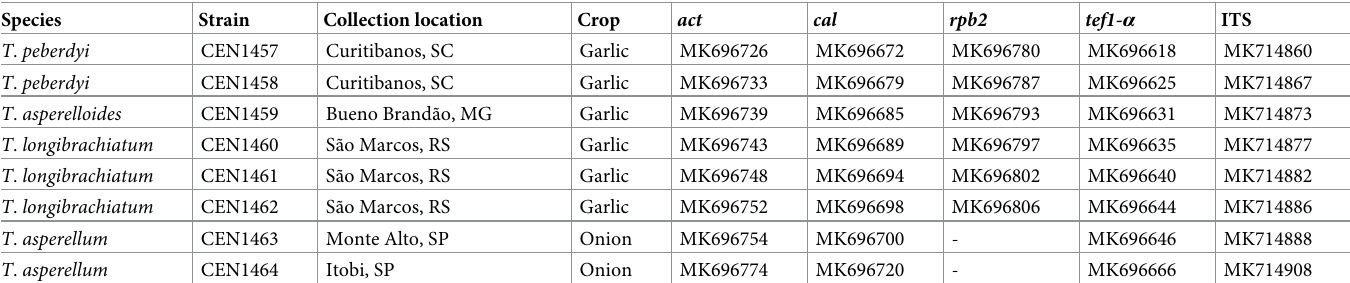
(v. 1.5, Technelysium Pty Ltd). Sequences, including references obtained from Genbank, were organized into matrices in Bioedit (v. 7.2.6) [26] and aligned using MAFFT v. 7 E-INS-i [27]. A concatenated matrix was assembled using Sequence Matrix (v. 1.8) [28]. An optimal partitioning scheme for each marker was determined in PartitionFinder 2 [35]. Maximum likelihood trees based on data from each marker as well as the concatenated matrix were constructed using IQ-TREE (v. 1.6.5) [36], where optimal nucleotide substitution models